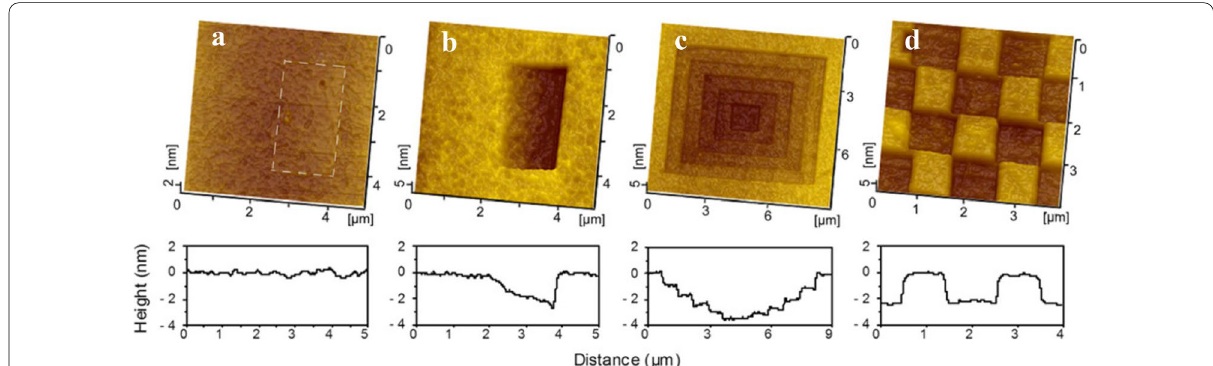
Figure 21 Friction-induced selective etching on quartz surface [80]: ( a ) A wearless area produced on quartz surface, ( b ) ‒ ( d ) An inclined surface, hierarchical stages, and chessboard-like patterns through the proposed